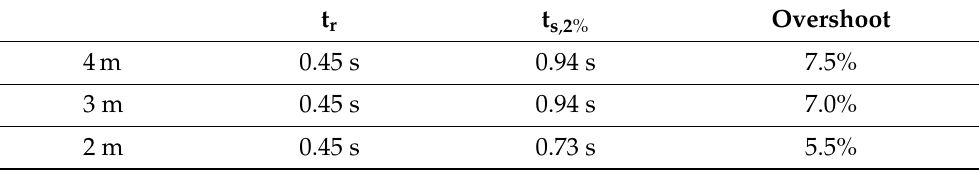
Table 3. Height overshoot for different altitudes for the MPC,